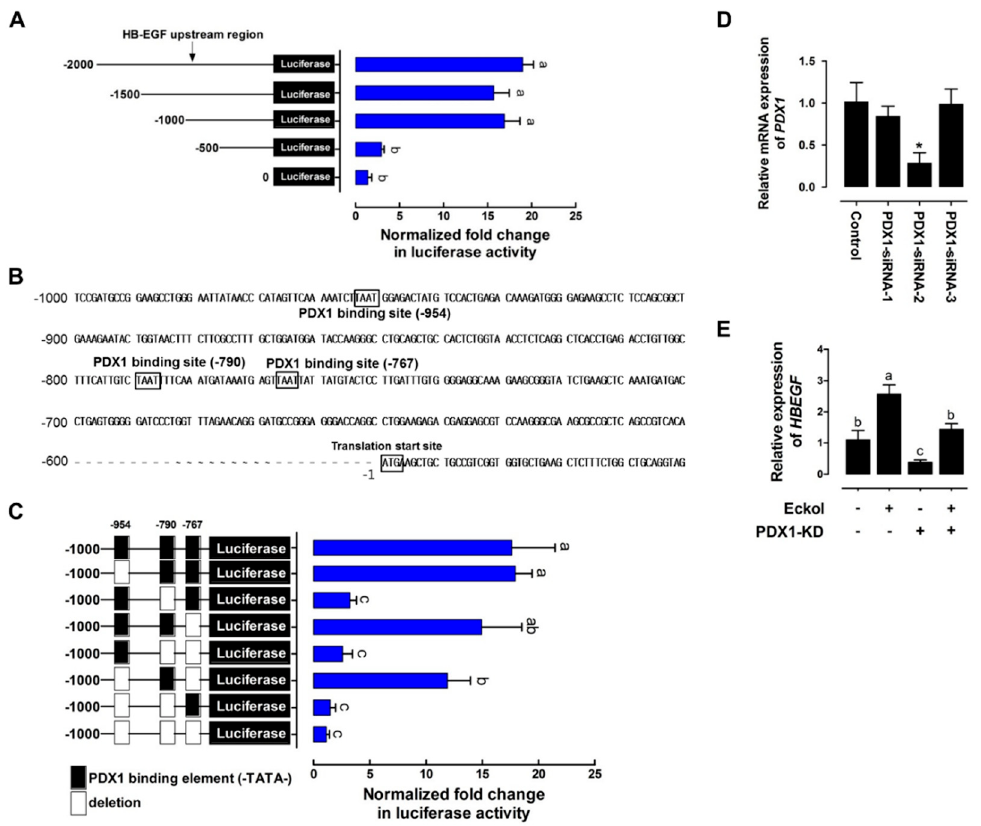
Figure 4. Eckol-induced PDX1 regulates HBEGF expression. ( A ) Activity of HBEGF upstream region. IPEC-J2 cells were transfected with DNA sequences of di ff erent lengths ( − 2000, − 1500, − 1000, and − 500) comprising the upstream region of HBEGF (n = 3). ( B ) Upstream sequence of the putative core region of the HBEGF promoter. Sequence numbering is relative to the transcription start site. Putative PDX1 binding sites (TAAT) are boxed and labeled above (upstream of − 954, − 790, and − 767). ( C ) Deletion assay of putative PDX1 binding sites. Sequences in which the deleted binding sites (upstream of − 954, − 790, and − 767) were transfected into IPEC-J2 cells (n = 3). ( D ) PDX1 knockdown assay. The siRNA-mediated suppression of PDX1 in IPEC-J2 cells was confirmed using qRT-PCR. ( E ) Relative HBEGF expression in PDX1 -silenced IPEC-J2 cells treated with eckol. Relative luciferase activity was calculated as the ratio of firefly to Renilla luciferase, and the relative expression level was normalized to that of glyceraldehyde 3-phosphate dehydrogenase ( GAPDH ). Error bars indicate standard error of triplicate analyses. * p < 0.05. Lower-case letters indicate significant di ff erences among treatments based on Duncan’s multiple range